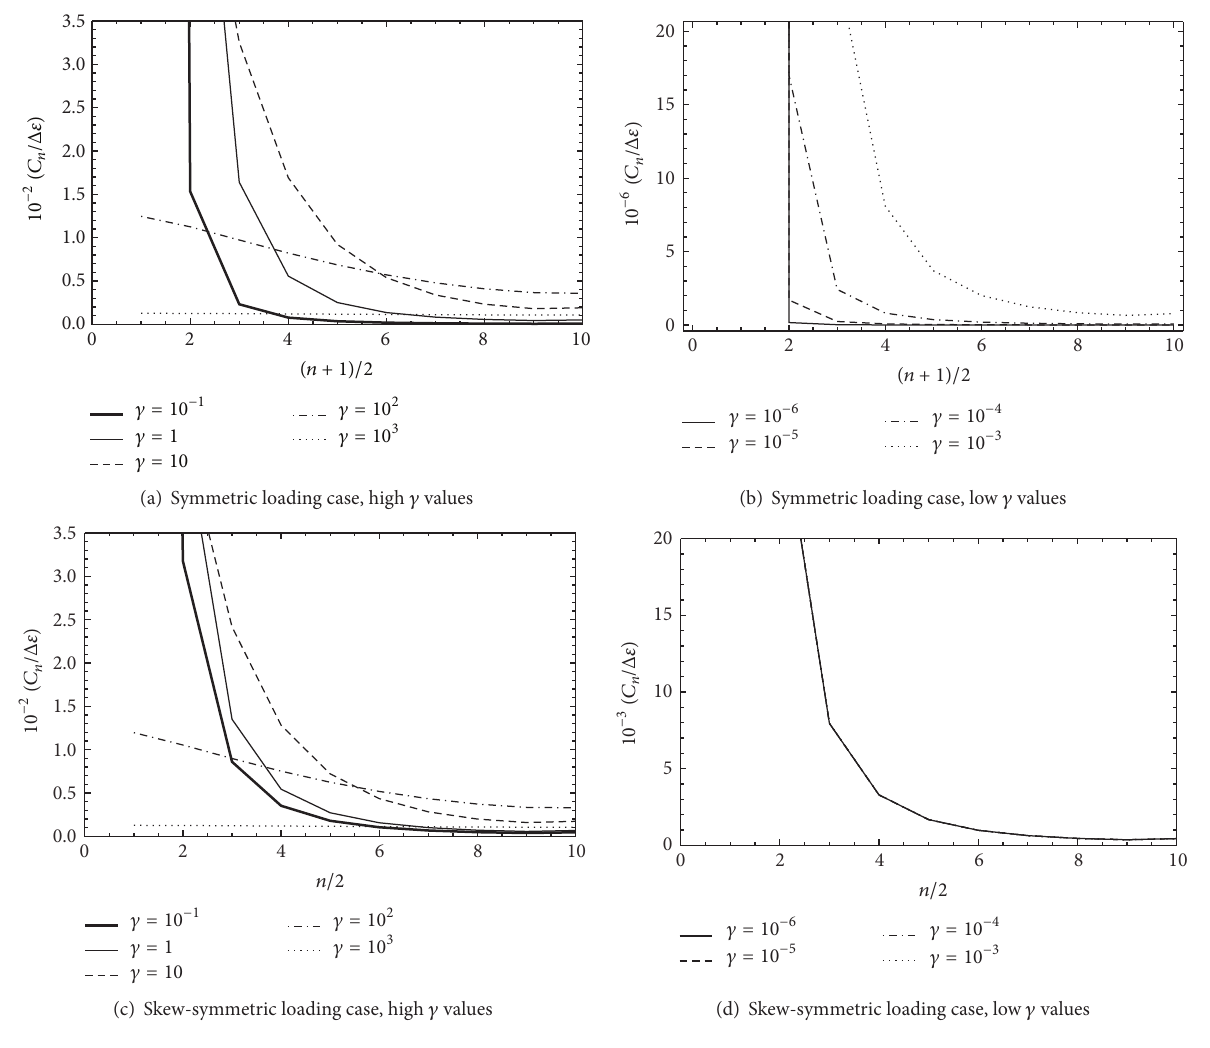
Figure 3: Convergence of Chebyshev coefficients.